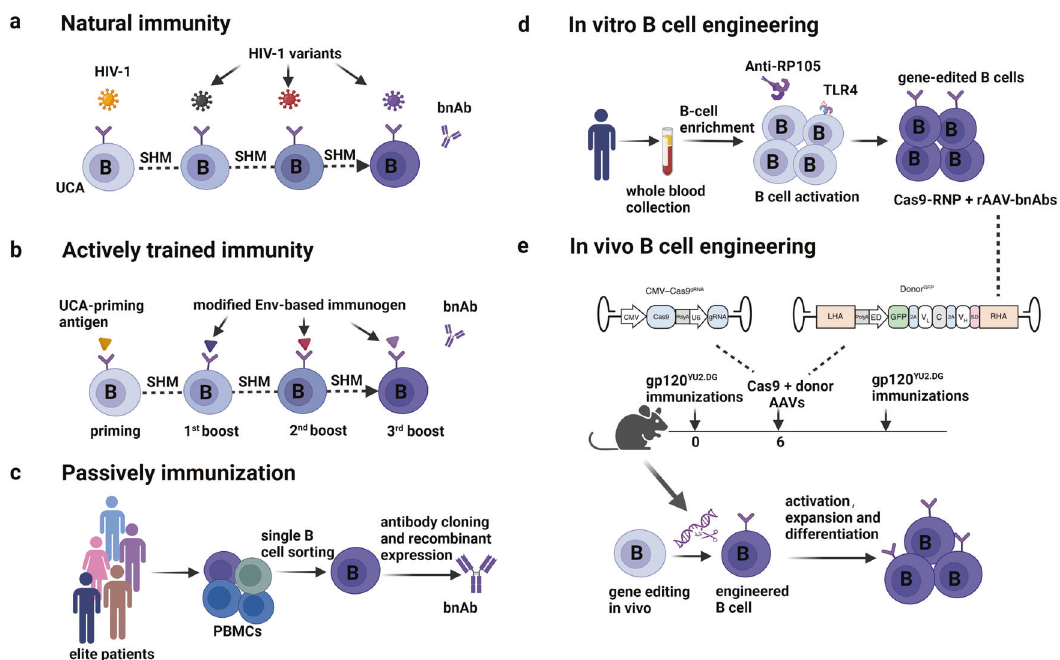
Fig. 1 Induction of anti-HIV-1 broadly neutralizing antibodies by natural immunity, trained immunity and engineered immunity. a The evolution of HIV-1 mutation is much faster than that of neutralizing antibodies, and bnAbs only might be developed in elite controllers by natural immunity. b The lineage-based vaccine is initiated by designing appropriate UCA antigens. Once triggered, Env-based modi fi ed immunogens might further promote lineage and bind to lineage intermediates and thus promote af fi nity maturation for the breadth of neutralization. c The monoclonal antibody is isolated by single B-cell PCR (polymerase chain reaction) from PBMCs of elite controllers and can be infused into HIV-1 patients for passive vaccination treatment. The bnAb gene is integrated into Ig locus of B cells using the CRISPR-Cas9- based in vitro B-cell engineering approach ( d ) or in vivo B-cell engineering approach ( e ), respectively. UCA Unmutated common ancestor, Env envelope, bnAbs broadly neutralizing antibodies, SHM somatic hypermutation, Anti-RP105 CD180/RP105 antibody, Cas9-RNP Cas9 ribonucleoprotein, TLR4 toll-like receptor 4, PBMCs peripheral blood mononuclear